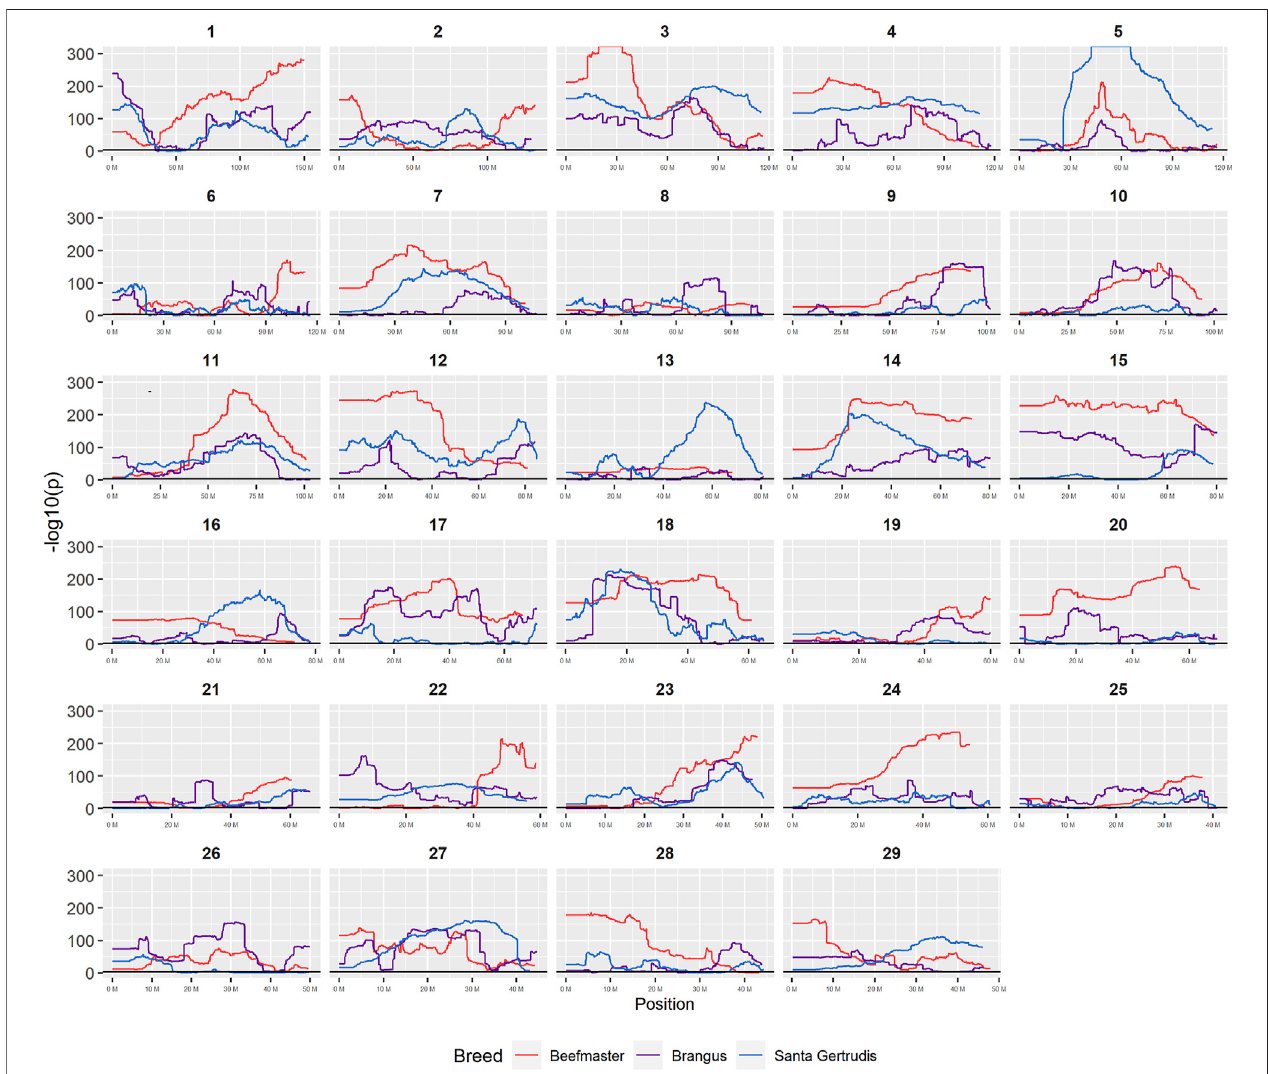
FIGURE 7 | Plots of − log 10 P for tests of each genomic window for deviation from breed expected Brahman proportion by